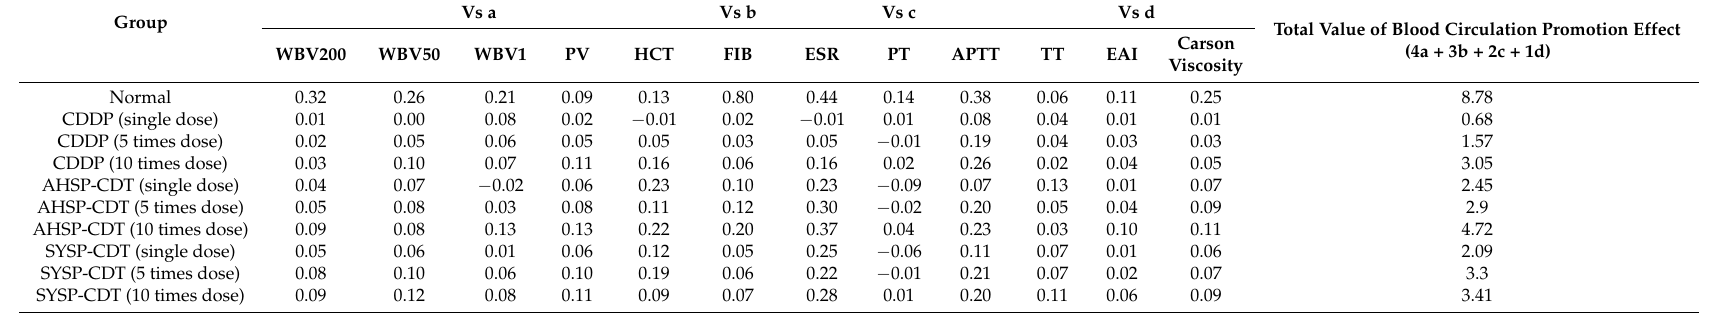
Table 1. The total value of the blood circulation promotion effect of Danshen preparations based on multi-index comprehensive index value. Group